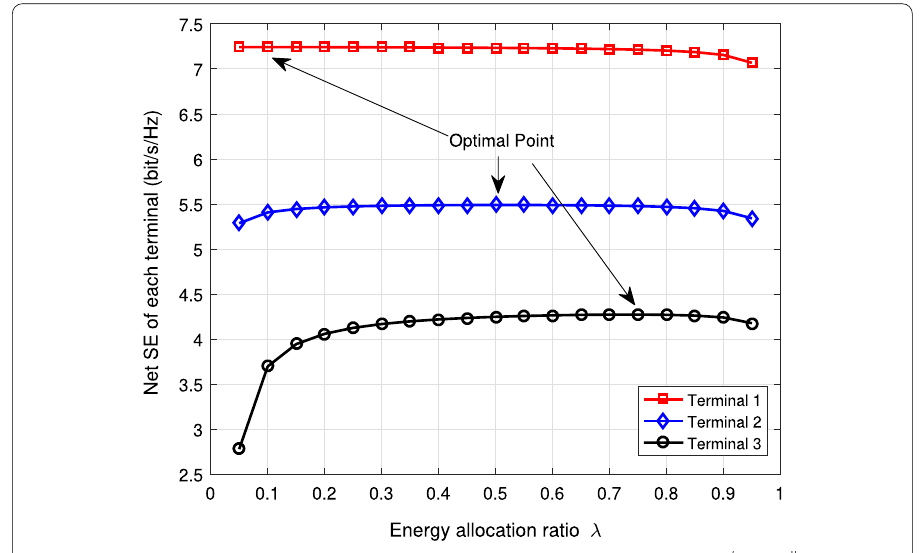
Fig. 8 Net SE of each terminal versus energy allocation ratio, where τ = 0.015 , α = 0 , C ul min = C dl min = 0 , θ = [ 1,1,1 ] T / 3 , and ρ = [ 0.5,0.5,0.5 ]